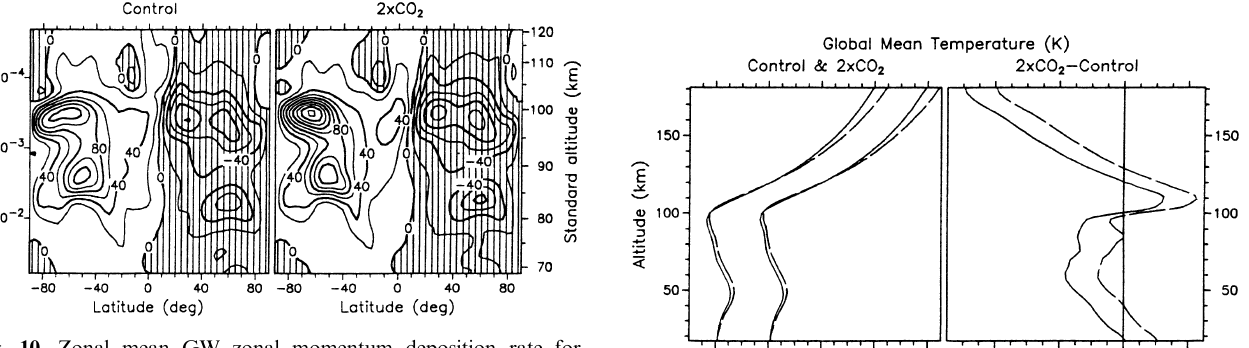
Fig. 10. Zonal mean GW zonal momentum deposition rate for January [contour interval 20 ms (cid:255) 1 day (cid:255) 1 , area of negative (westward) acceleration shaded ]: control experiment ( left panel ); 2 (cid:2) CO 2 ( right panel )